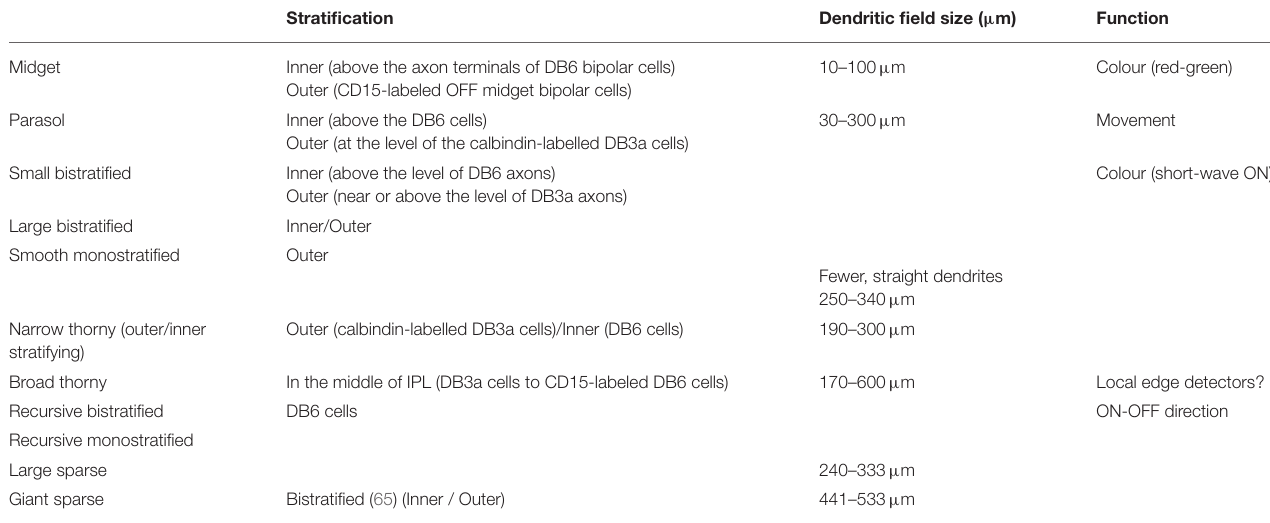
TABLE 4 | The classification of retinal ganglion cells in